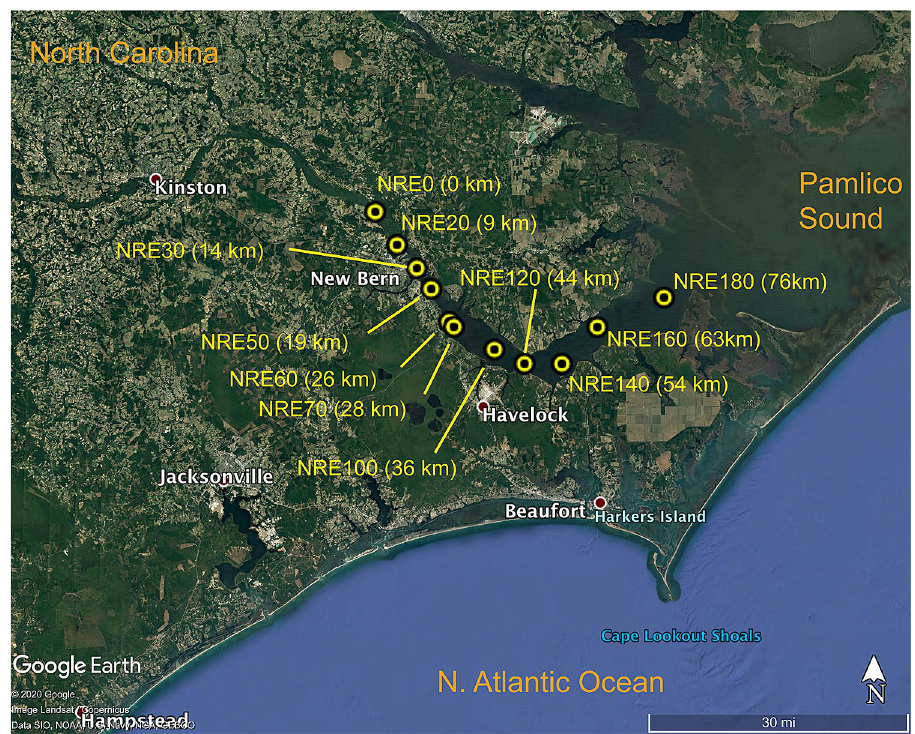
Figure 1. Neuse River Estuary (NRE) stations sampled in this study. The distance down river from station NRE0 is provided in parenthesis. NRE stations are those established as part of the MODMON monitoring program. The underlying map image was retrieved using Google Maps Pro version 7.3.3.7786 (https ://www. googl e.com/earth /versi ons/#downl